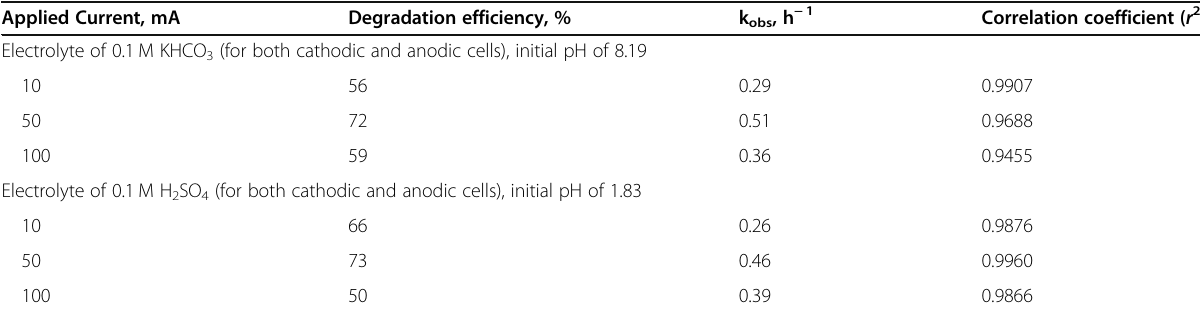
Table 1 Rate constants of the pseudo-first-order equation obtained under various electrochemical oxidation conditions Applied Current, mA Degradation efficiency,